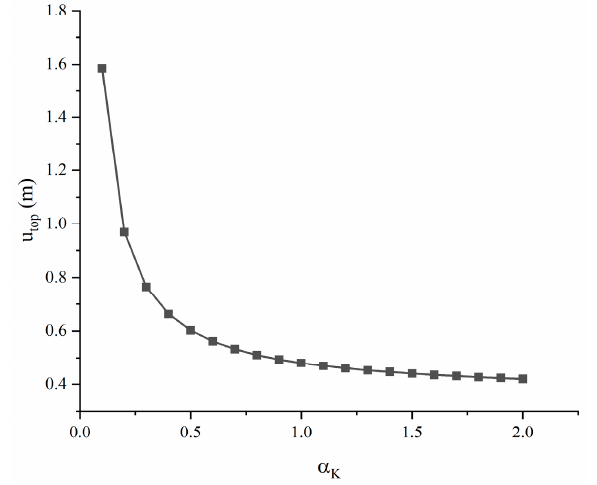
Figure 11. The influence of the foundation impedance on the tower displacement.